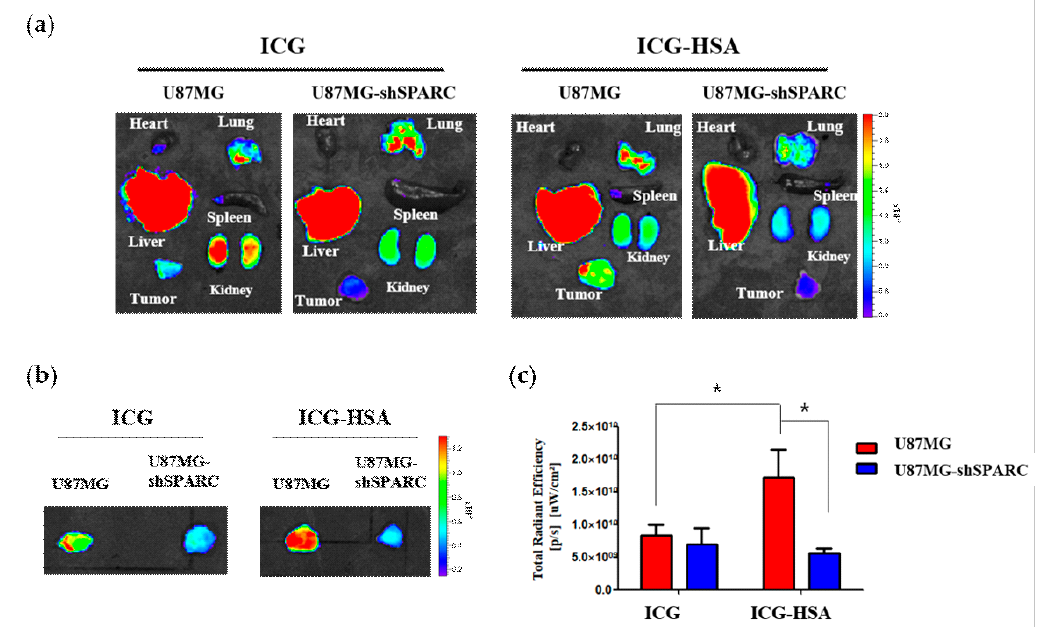
Figure 4. Ex vivo fluorescence imaging of ICG-HSA complex in U87MG and U87MG-shSPARC tumor models. ( a ) Ex vivo fluorescence images of tumors and organs 1 h after the injection of ICG or ICG-HSA; ( b ) ex vivo fluorescence images of tumors with 10 sec exposure time; ( c ) fluorescence intensity of tumors region. *: p < 0.05.